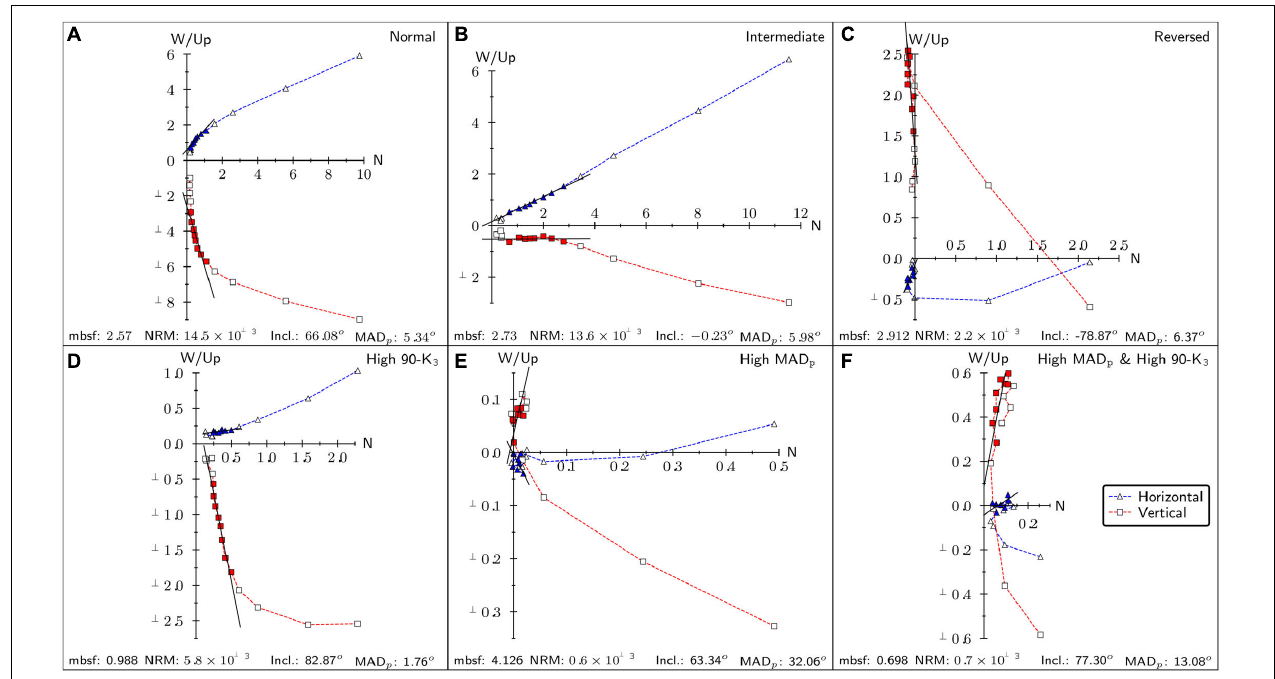
FIGURE 3 | Orthogonal projections of alternating field demagnetisation data for six selected samples from 13PC. Axis units are in mA/m, NRM values are in A/m. All samples show the removal of a potential viscous component followed by the demagnetisation of one component toward the origin. Samples (A,D) show curved demagnetisation behaviour, indicative of 2 (or more) directional components. Sample (B) shows a strong horizontal magnetisation. Sample (C) shows a low coercivity horizontal component and a steep negative component. Samples (E,F) display rapid demagnetisation within the first few steps (15–20 mT) followed by erratic